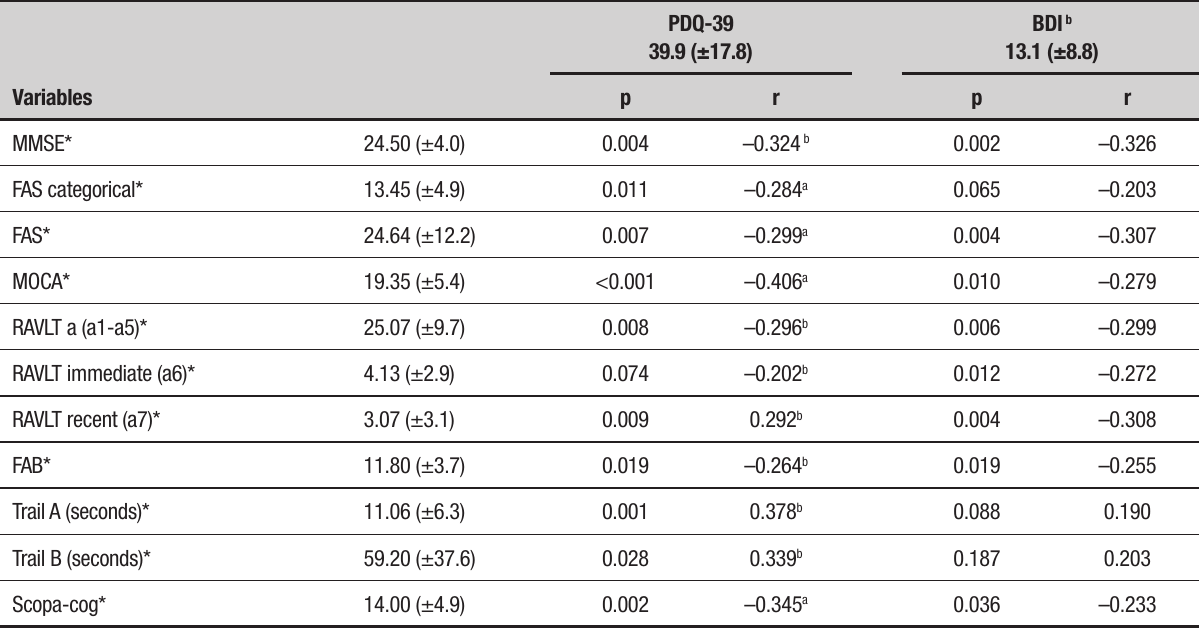
Table 1. Correlation of quality of life and depression with cognitive tests.